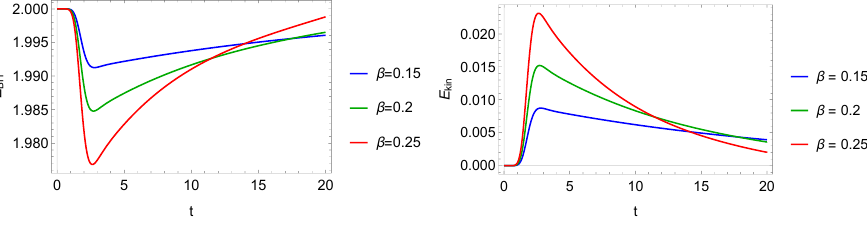
Figure 4. Evolution of the black hole energy and the kinetic energy in the left and right panel, respec- tively, for a variety of